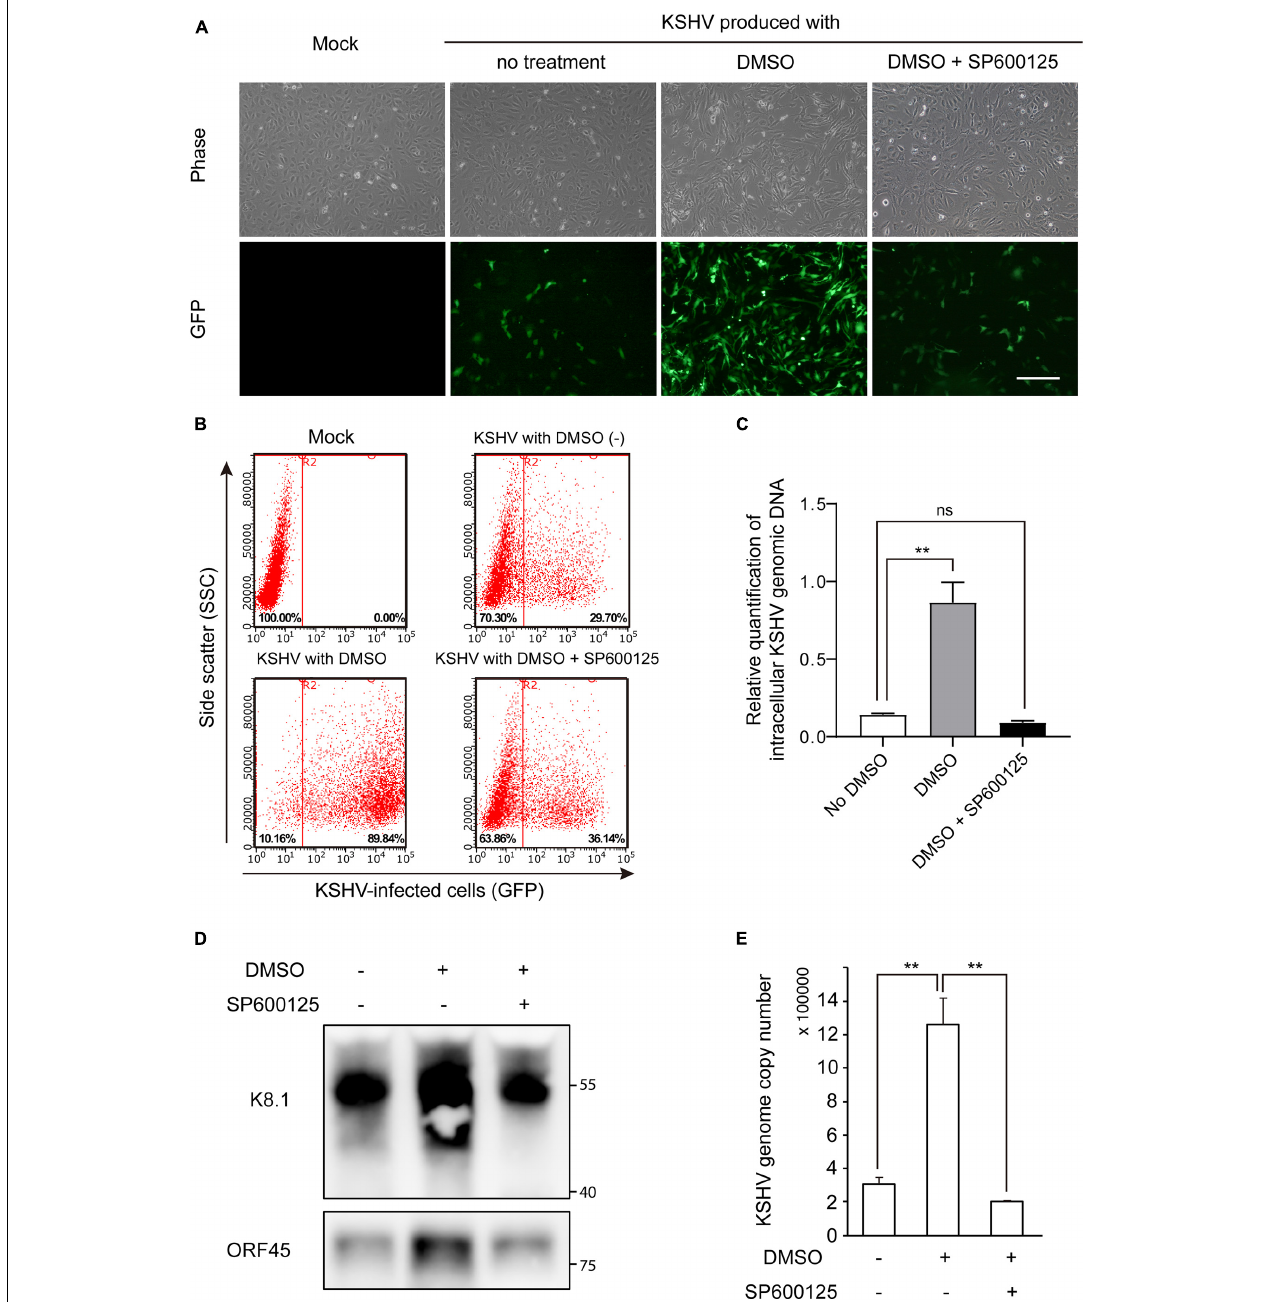
FIGURE 8 | JNK inhibitor suppressed DMSO-mediated enhancement of KSHV virion production in iSLK BAC16 cells. iSLK BAC16 cells were treated with the JNK inhibitor SP600125 (20 µ M) at the beginning of lytic activation with DMSO. After 2 days, KSHV was harvested from each culture supernatant. The same volume of KSHV from each group was used to infect HUVECs. (A) GFP expression of KSHV-infected cells, as evaluated by fluorescence microscopy. After 24 h of infection, GFP expression was observed using fluorescence microscopy. Scale bar = 250 µ m. (B) Representative results of flow cytometric analysis of GFP expression in KSHV-infected HUVECs. GFP-expressing cells from panel (A) were detached and analyzed by flow cytometry. X - and Y -axis indicate GFP expression and side scatter, respectively. The numbers in the right lower corners of each panel indicate the percentage of GFP-positive cells. (C) qPCR for KSHV genomic DNA in KSHV-infected HUVECs. KSHV from each experimental group (no DMSO, DMSO alone, and DMSO with SP600125) was used to infect HUVECs, and genomic DNA was extracted at 4 h postinfection. Data are shown as the mean ± SD, n = 3, and ns, not significant. ** p < 0.01. (D,E) Attenuated KSHV production by JNK inhibitor. After induction of lytic replication, KSHV was extracted from the supernatants of iSLK BAC16 cells. iSLK BAC16 cells were treated with DMSO or SP600125 during lytic replication. The same volume of extracted KSHV from each experimental condition was analyzed. Western blot analysis of KSHV proteins of the isolated KSHV virions (D) . Analysis of KSHV genome copy numbers from the produced virions (E) . Genomic DNA was isolated from the extracted virions and analyzed by qPCR with specific primers targeting KSHV ORF26 . Data are shown as the mean ± SD, n = 3, and ** p < 0.01.